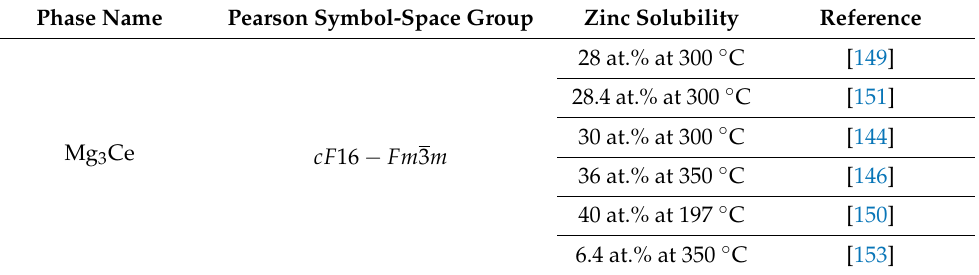
Table 2. Crystallographic data and Zn solubility in Mg 3 Ce.